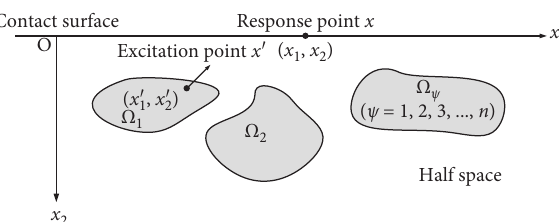
Figure 2: Half space with n arbitrary-shaped inclusion domains Ω